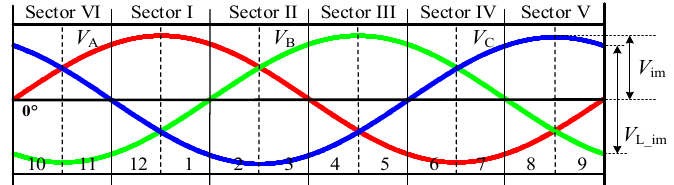
Figure 2. Three-phase input voltages and sectors.